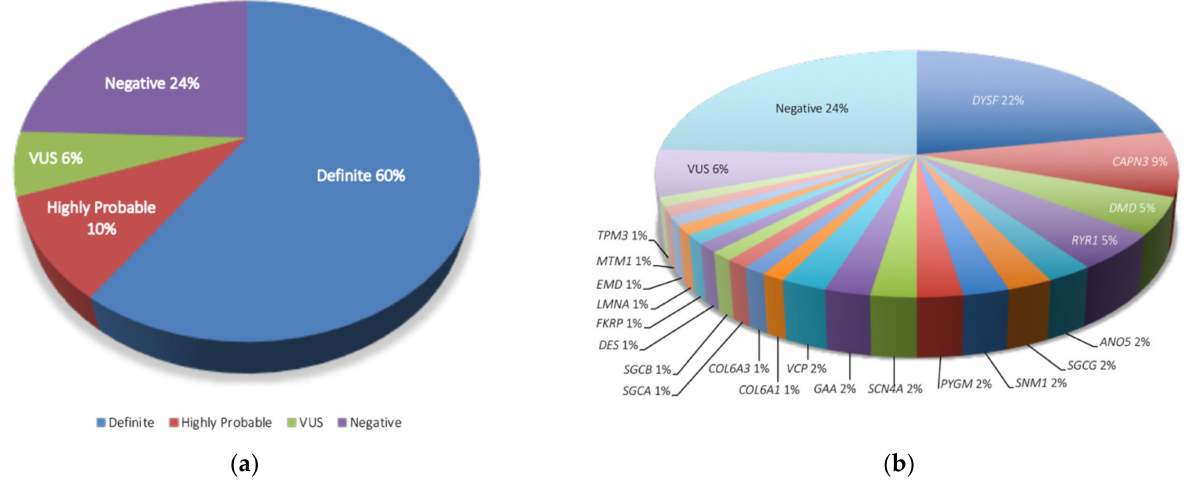
Figure 2. Diagnostic yield of the study: ( a ) percentage of patients with a definite genetic diagnosis, highly probable genetic diagnosis, negative diagnosis or variants of unknown significance (VUS). ( b ) number of patients with a definite diagnosis by gene, VUS or absence of causative mutation (i.e., negative). No disease-causative variants were identified in 25 cases (30.5%), including 5 cases (6.1%) that were considered partially solved, which corresponded to patients with VUS partially matching the phenotype (i.e., P6-Myo031 and P57-Myo141 ( TTN ); P42-Myo104 ( DYSF ); P62-Myo141 ( RYR1 ); P65-Myo143 ( SYNE2 )). The relative frequency of the